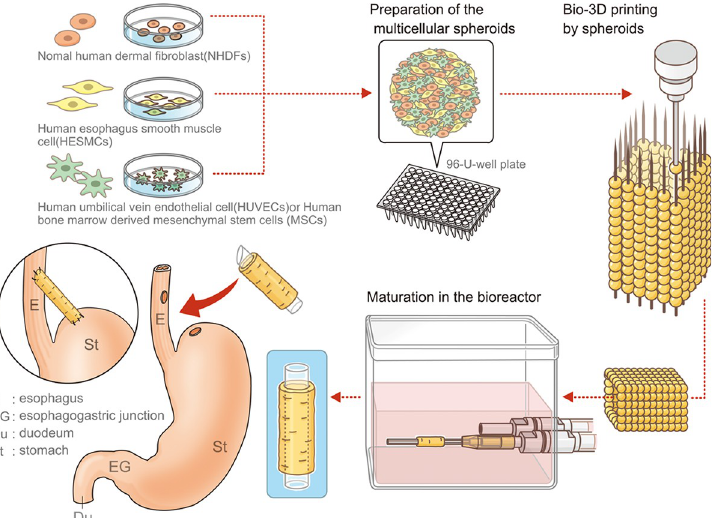
Fig 1. Study overview. Cells: fibroblasts, mesenchymal stem cells, smooth muscle cells, or endothelial cells were cultured respectively. Multicellular spheroids were created using mixed cell suspensions, and the artificial esophagus was then constructed with bio-3D printing using those spheroids. The artificial esophagus was matured in a bioreactor for a total of 4 weeks. Finally, esophageal transplantation of the artificial esophagus was performed.